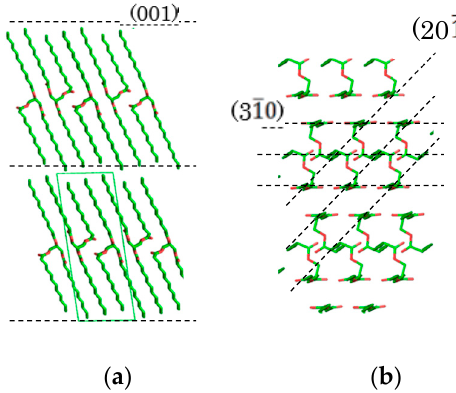
Figure 1. Crystal structure of trilaurin. ( a ) Lamella and (001) face and ( b ) subcell packing and (20-1) and (3-10) faces. The crystal structure was drawn using the PyMol software package [24].